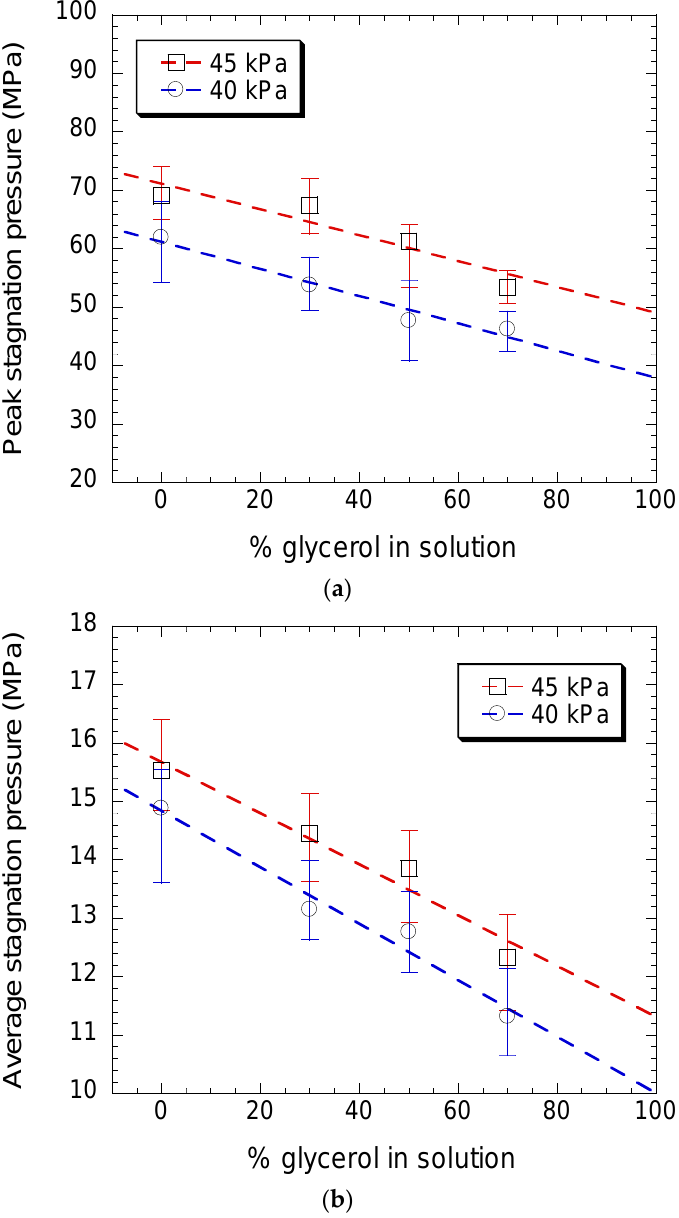
Figure 11. Results of the ( a ) peak pressure; and ( b ) average stagnation pressures as a function of the % glycerol in the solution, respectively. The dashed lines show the trend lines of the experimental results.